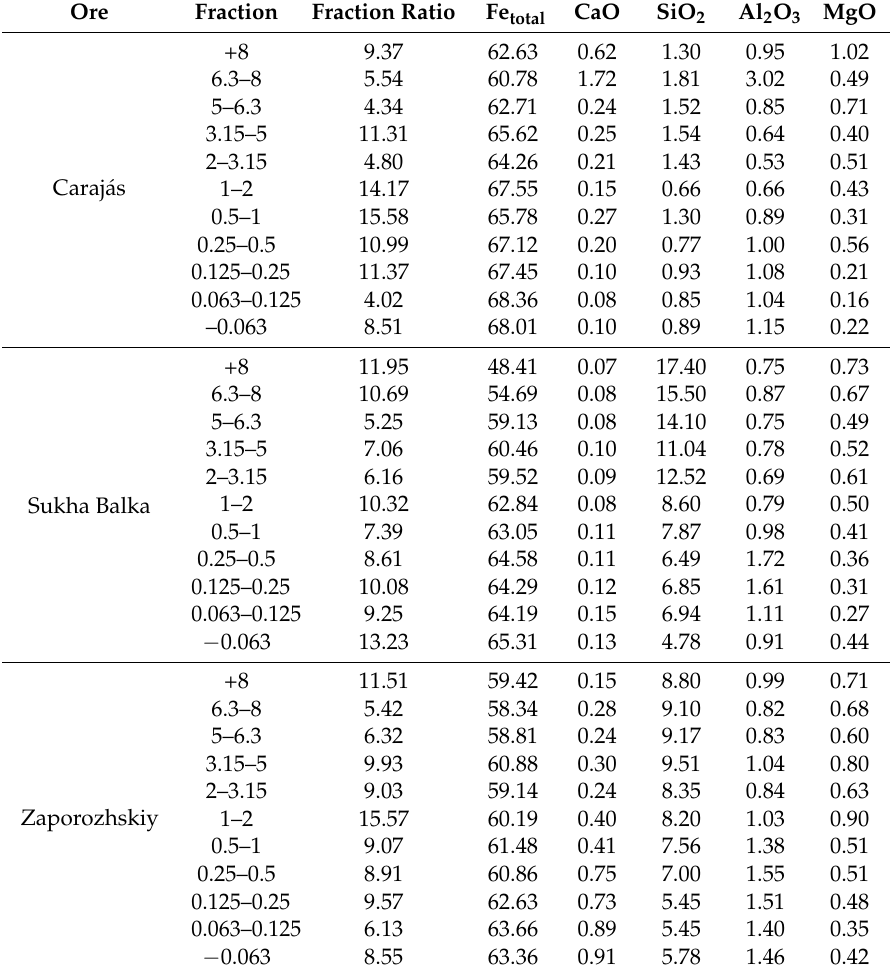
Table 2. Chemical composition of iron ores, according to their size distributions in mm, dry wt %.